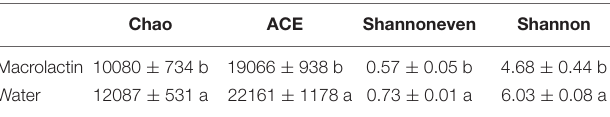
TABLE 2 | α -diversity indexes of soil microbial community in both macrolactin treated soil and water control soil evaluated by 16S rRNA gene